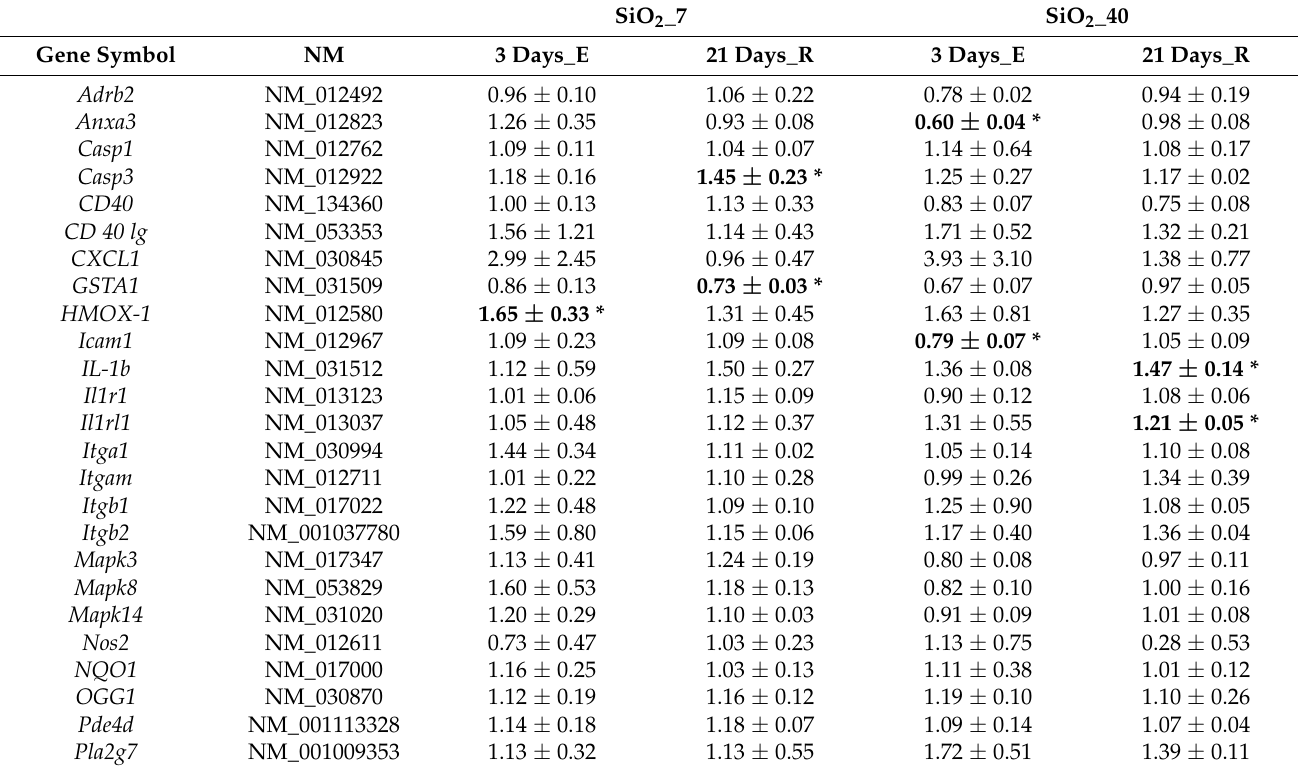
Table 7. Gene expression profile identified by TAC analysis following instillation of SiO 2 _7 or SiO 2 _40 in